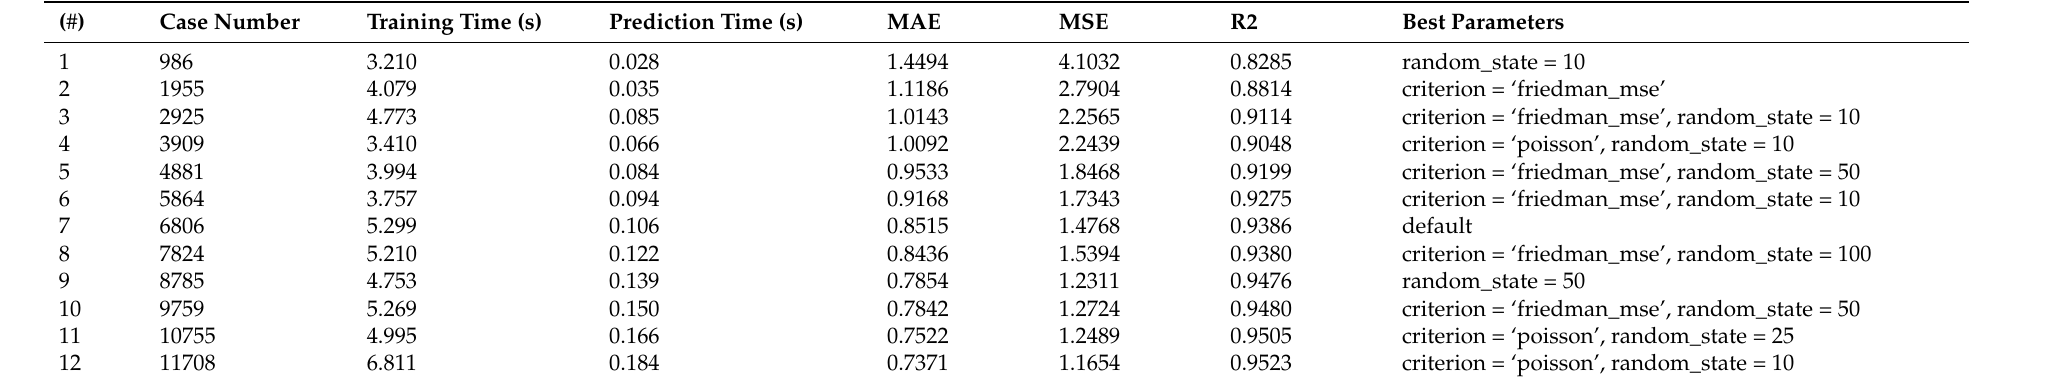
Table A1. Results of running the model with: DecisionTreeRegressor.